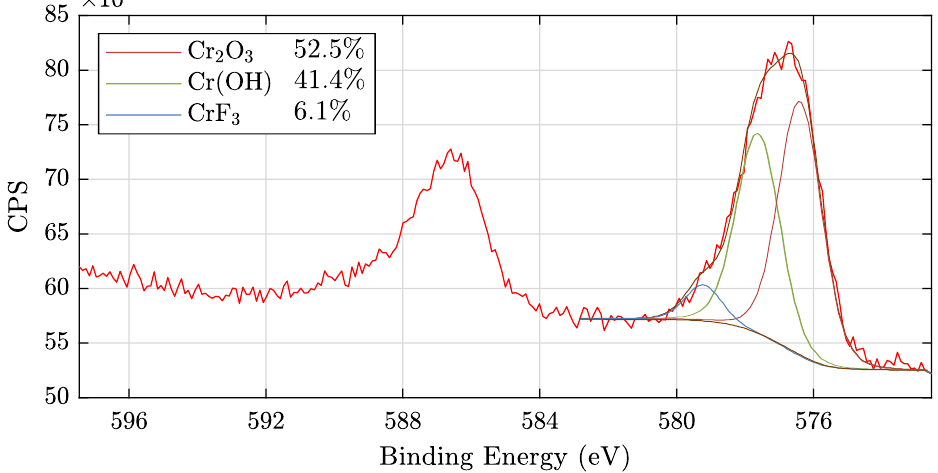
Figure 5. High resolution XPS spectrum and curve fitting for the Cr 2p photoelectron region for specimen PT4.